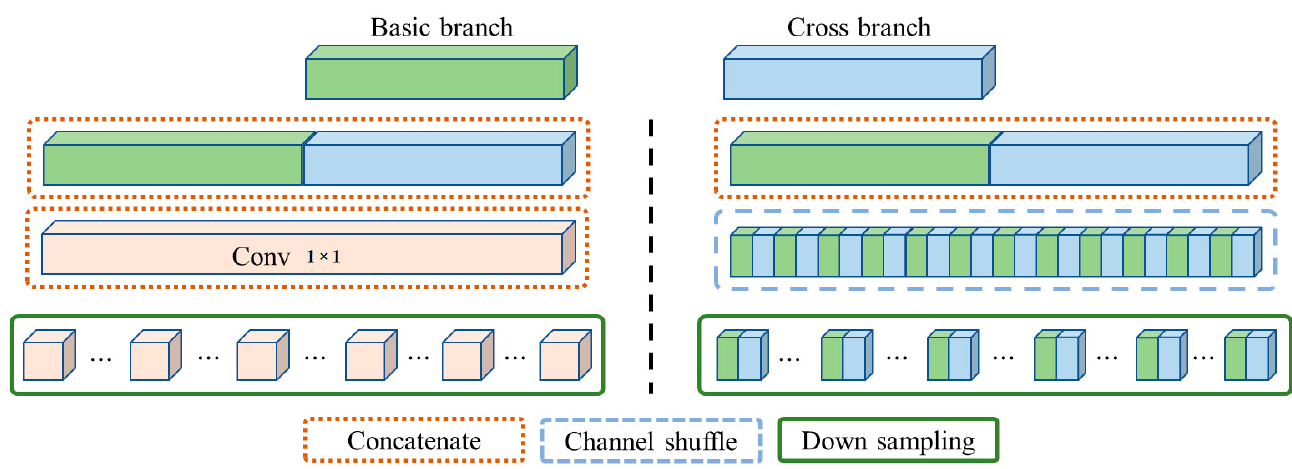
Figure 5. Schematic of channel shuffle